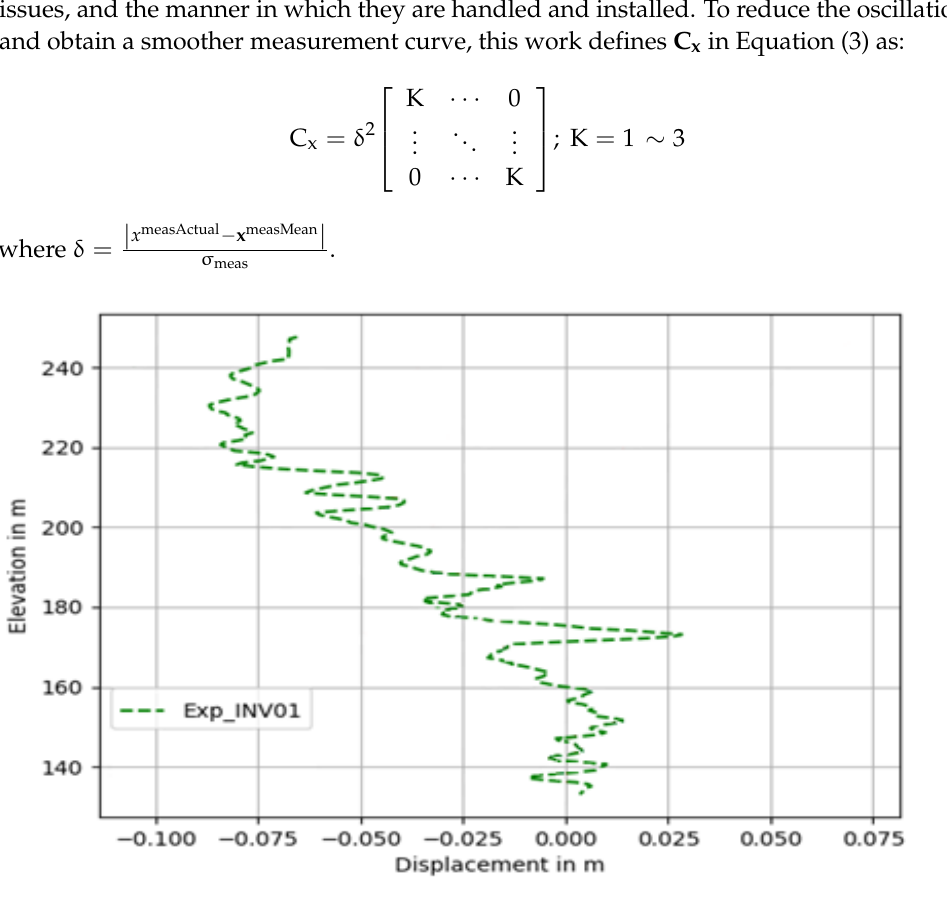
Figure 2. Measurements recorded by INV01 prior to the start of impoundment, denoted by the dotted line. These denote horizontal movements; a negative value indicates upstream movement.